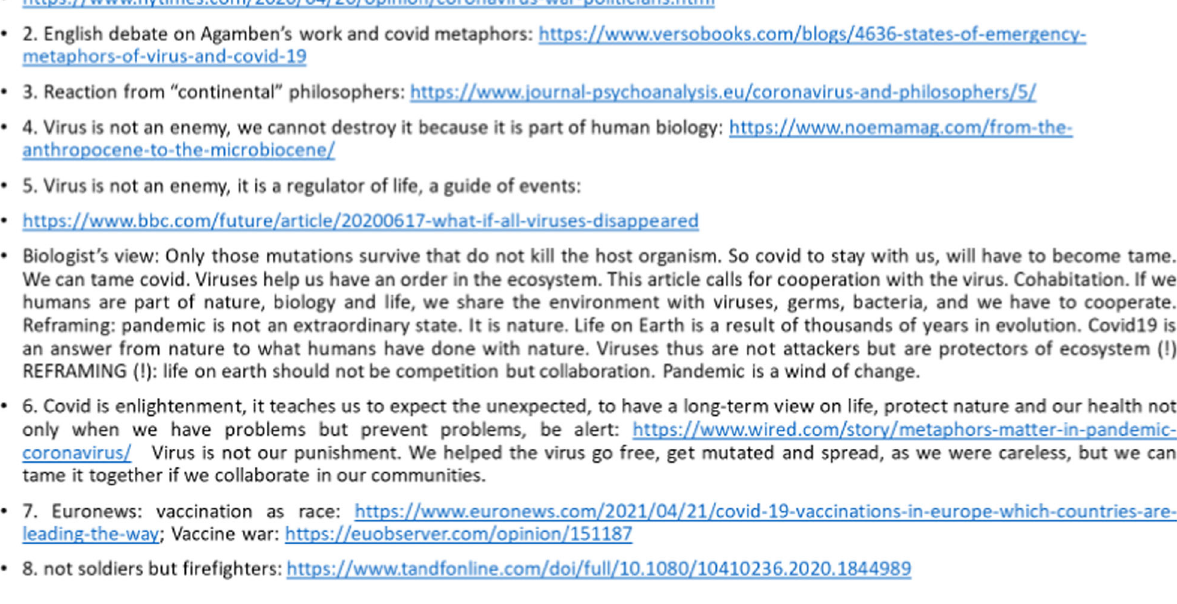
Fig. 9 The different conceptualizations of Covid-19 in an intra-cultural